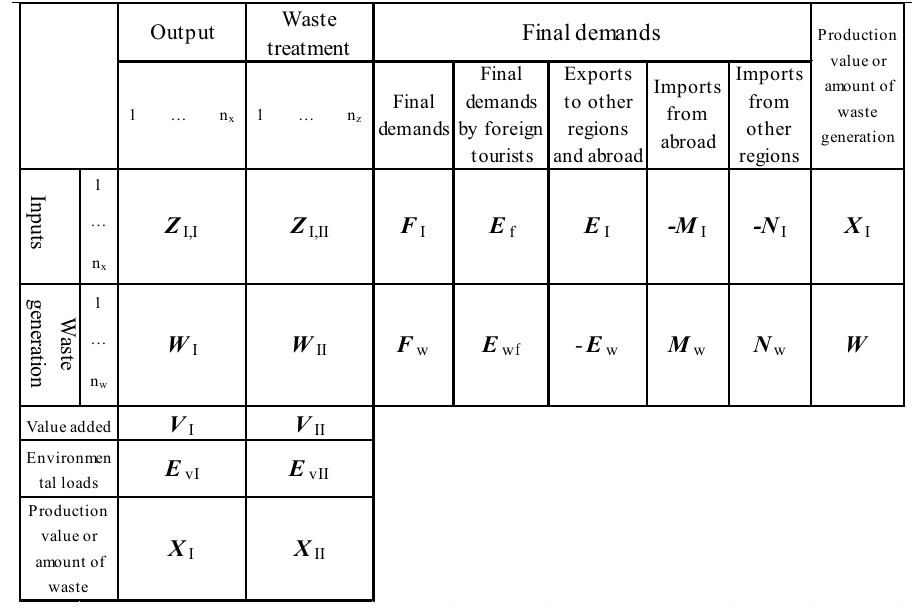
Table 1 Framework of regional waste input–output